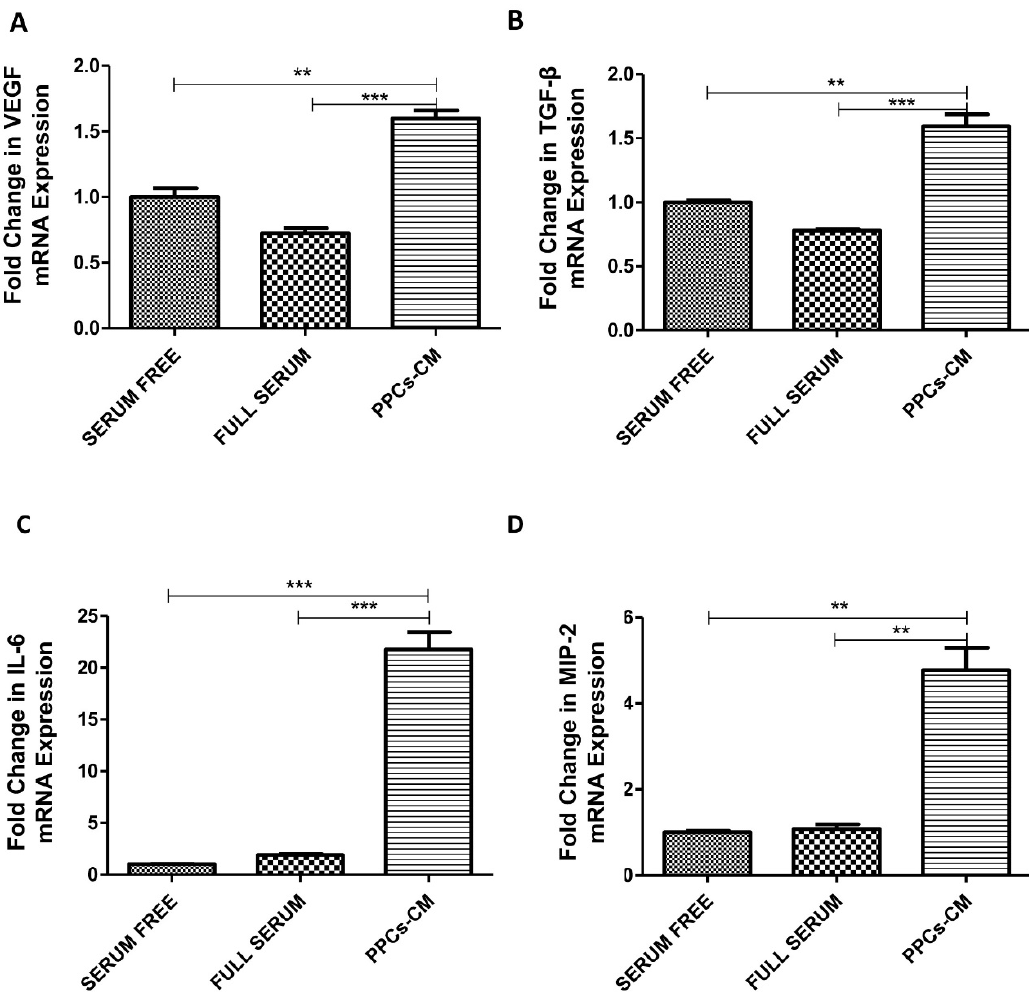
Figure 7. PPC-mediated increase in the expression of angiogenic factors of MSCs. ( A – C ) Real-time PCR was performed to measure the mRNA level of angiogenic factors VEGF, TGF- β , and IL-6 under the PPCs-CM condition or serum-free condition. (n = 3 per group; * p < 0.05, ** p < 0.01, *** p < 0.001. All data are expressed as means ± SEM).